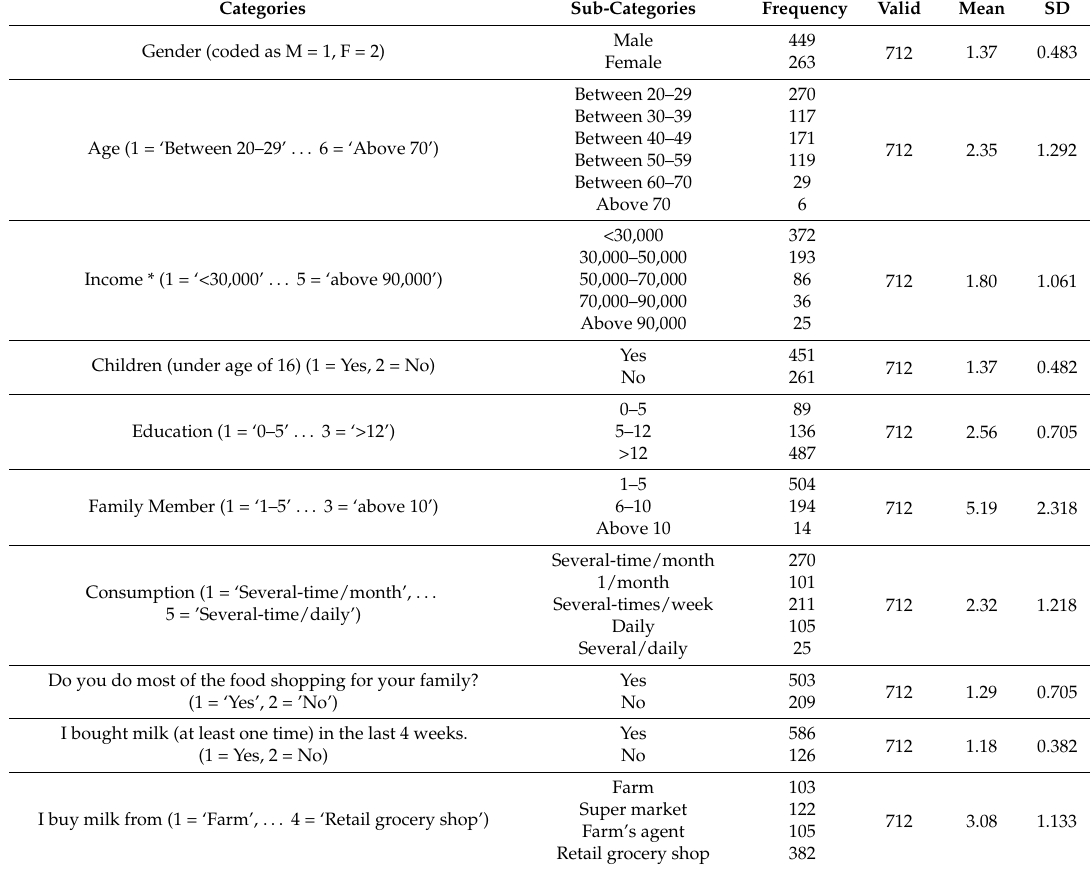
Table 1. Demographic profile of the